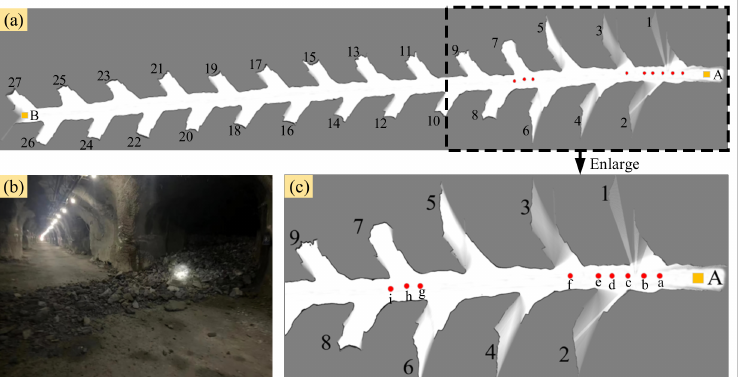
Figure 3. The laneway of Mine B for which dataset 2 was collected. ( a ) the map; ( b ) the view of the laneway; ( c ) a zoomed-in view of the map. Note: a–i in ( c ) are the sampling points of the map. A and B in ( a ) is the starting point and ending point of the laneway.